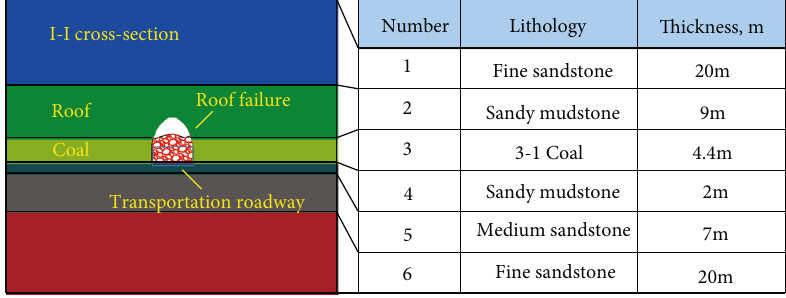
Figure 2: Rock strata histogram at the 113101 main roadway.